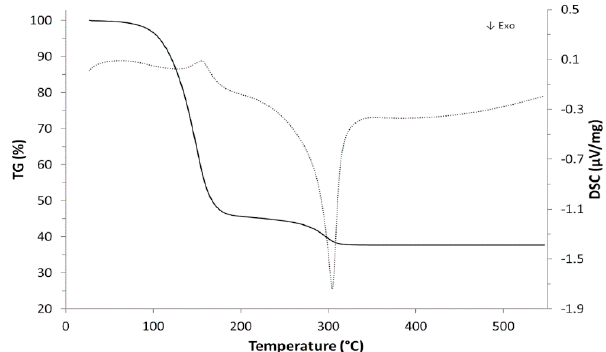
Figure 4. TG–DSC analysis of one of the inks produced.